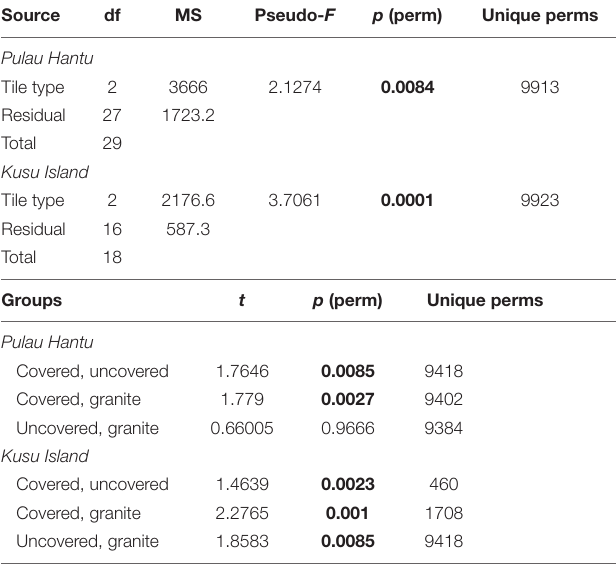
TABLE 2 | PERMANOVA results based on Bray–Curtis dissimilarities of the relative abundances (pre-treated with log[X + 1] transformation) of 56 different species in response to the tile type